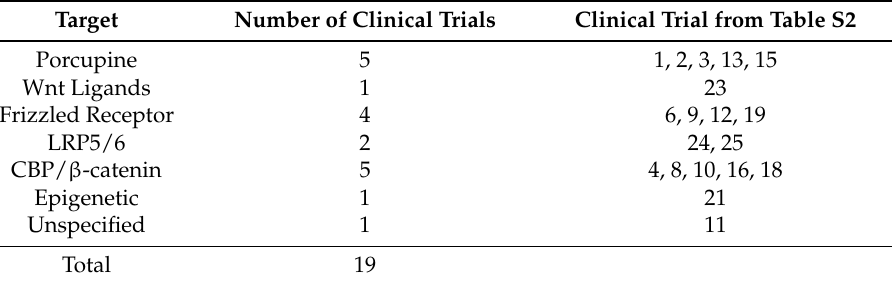
Table 4. Wnt signaling inhibition targets.